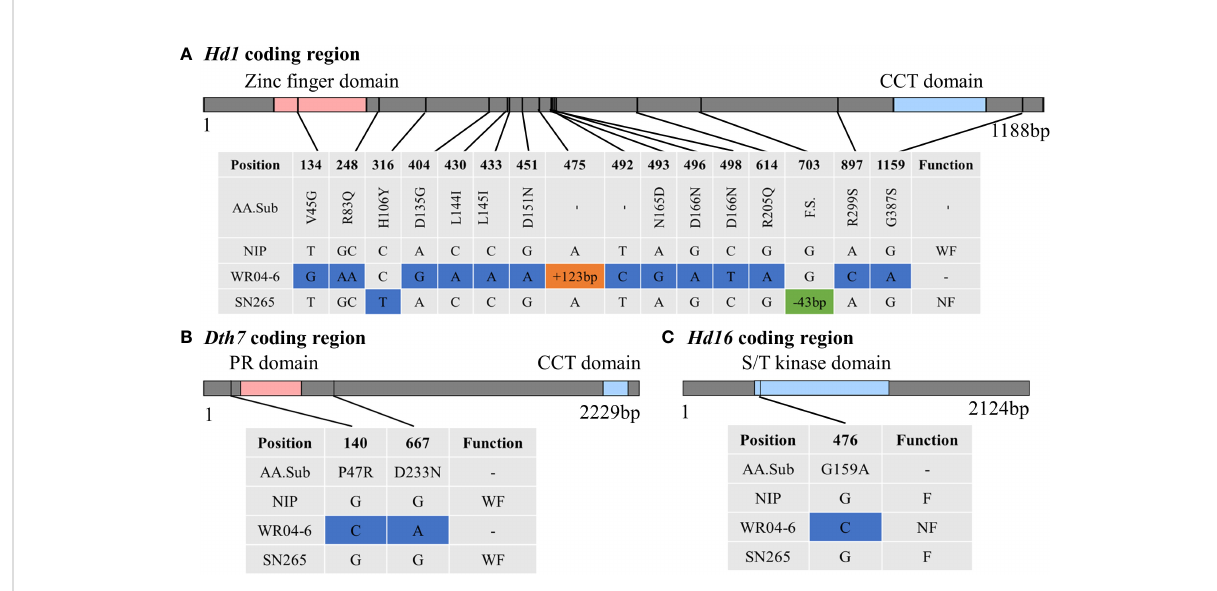
FIGURE 5 Genotype analysis between the weedy rice WR04-6 and japonica cultivar SN265. (A) The variation of Hd1 between WR04-6 and SN265 with Nipponbare genotype as a reference in the coding region. (B) The variation of Dth7 between WR04-6 and SN265 with Nipponbare genotype as a reference in the coding region. (C) The variation of Hd16 between WR04-6 and SN265 with Nipponbare genotype as a reference in the coding region. The blue box indicates a single base variation; the orange and green boxes represent insertion and deletion, respectively. F, Functional; WF, Weak functional; NF, Non-functional. The gray top bar represents the coding region; the colorful region means the domain of the